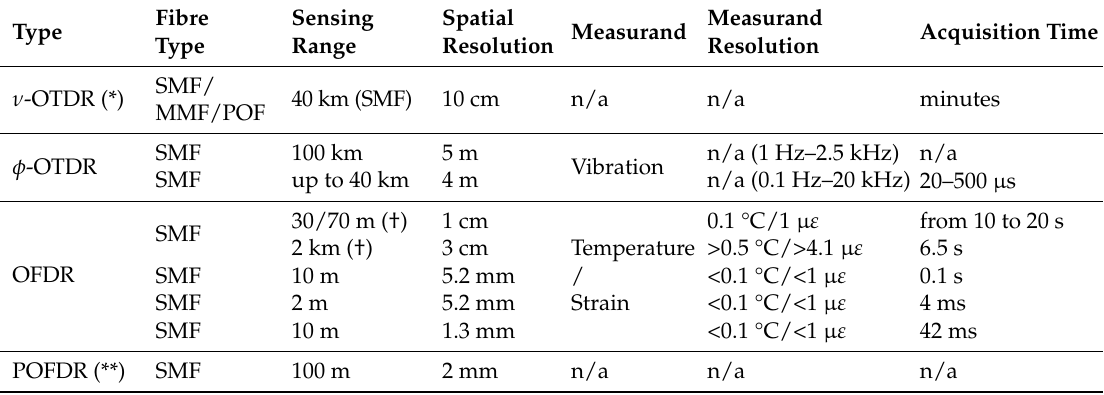
Table 1. Performances of some commercial Rayleigh-based interrogators (sources: producers’ datasheets, technical notes, and scientific